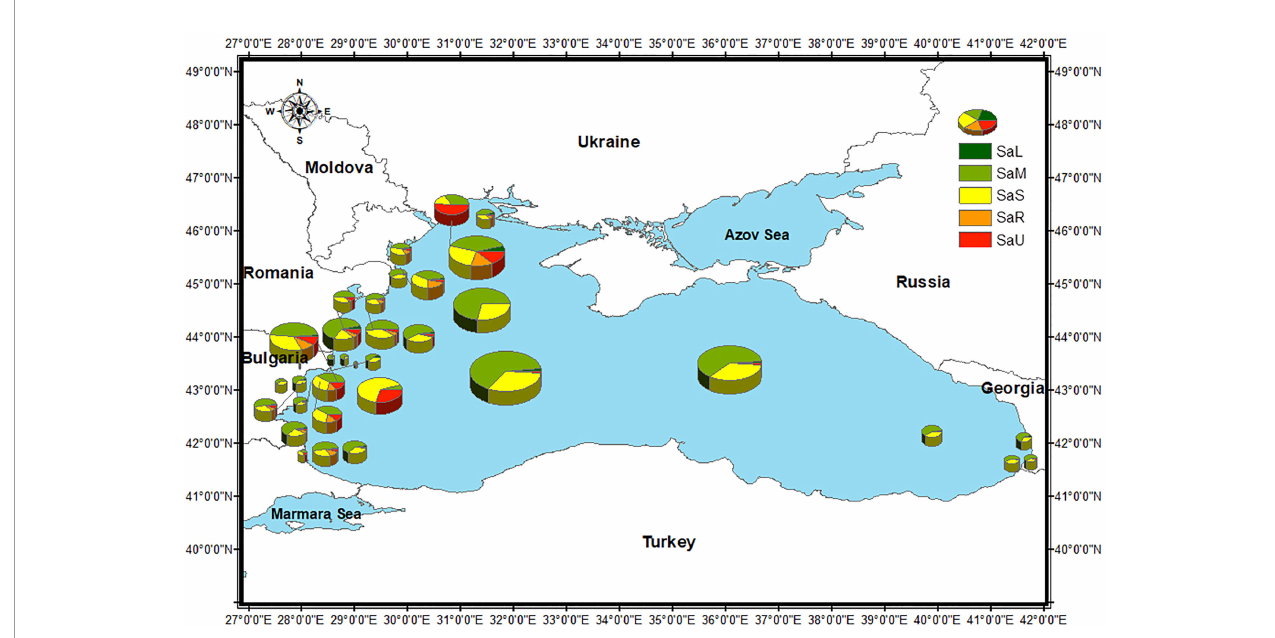
FIGURE 4 | S. acuminata morphotypes distribution and % of the total abundance of S. acuminata viable cysts in the Black Sea, by sampling stations (for the stations with repetitive sampling, the maximum abundance is shown). Size of the pies corresponds to total S. acuminata cyst abundance ( Table 2 ).